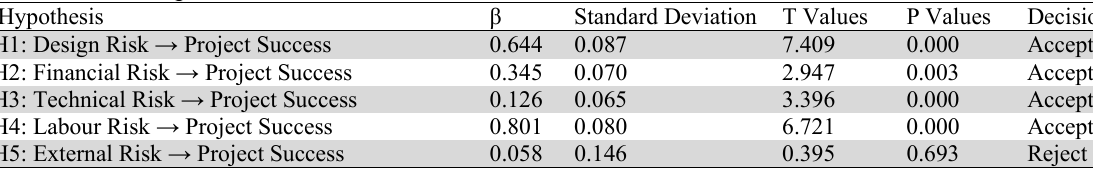
Direct relationship results